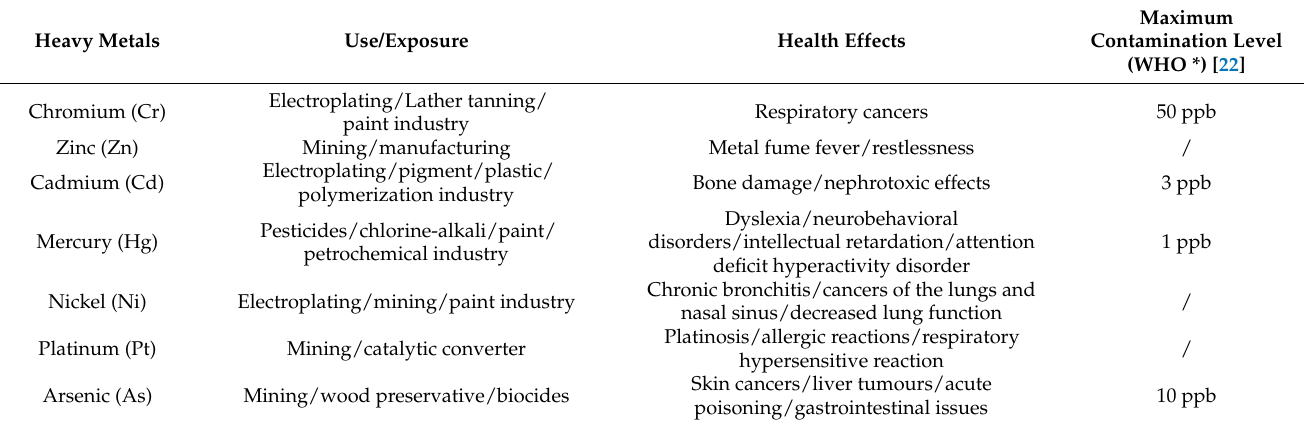
Figure 1. Schematic diagram of photocatalytic treatment of heavy metals. Table 1. Health effects of exposure to several heavy metal elements (Adapted from [21]).